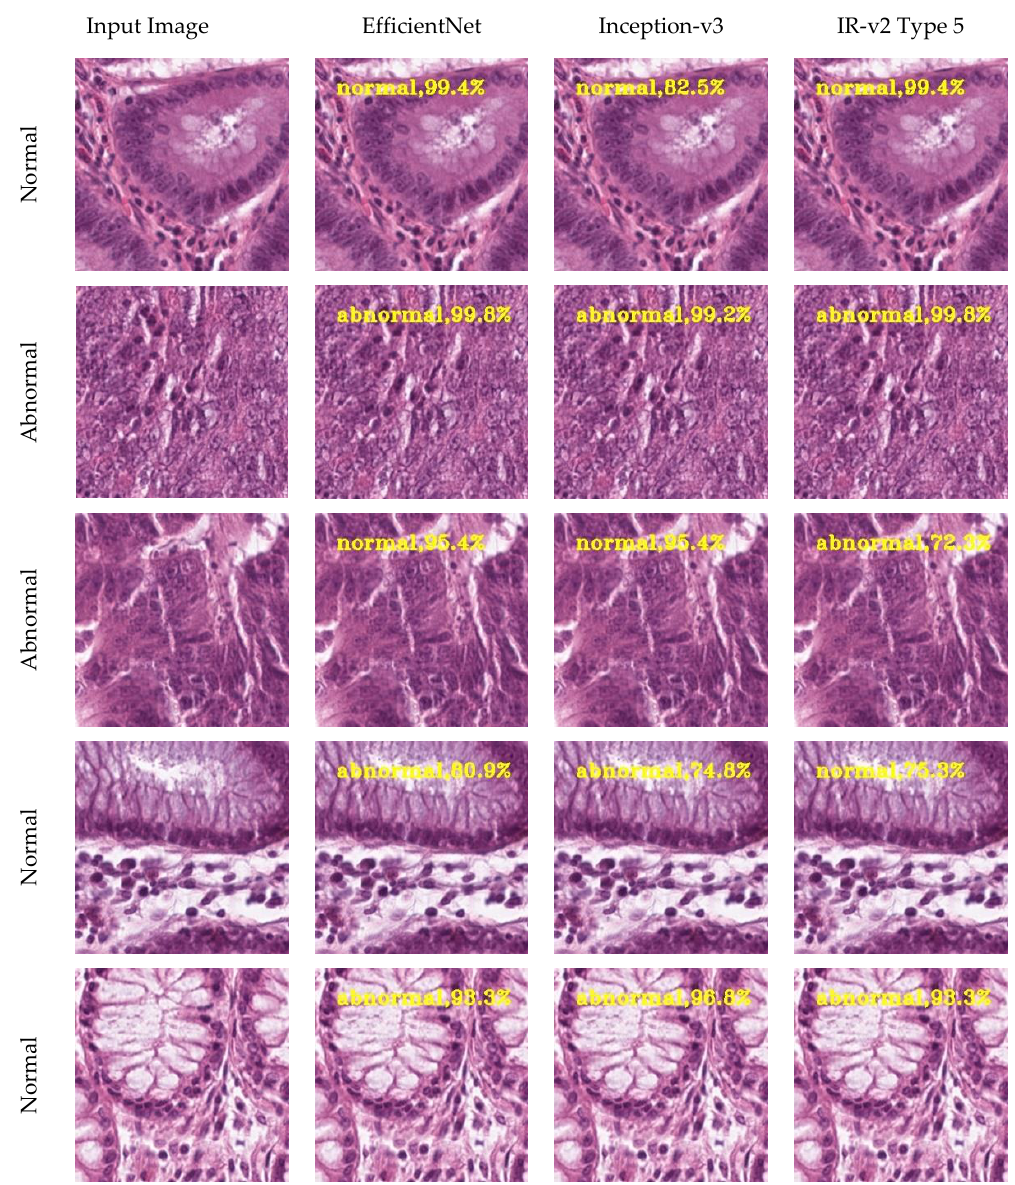
Figure 12. Comparison of outputs generated by the models: column 1: input image; column 2: classified outputs produced by EfficientNet; column 3: classified outputs produced by Inception-v3; and column 4: classified outputs produced by IR-v2 Type